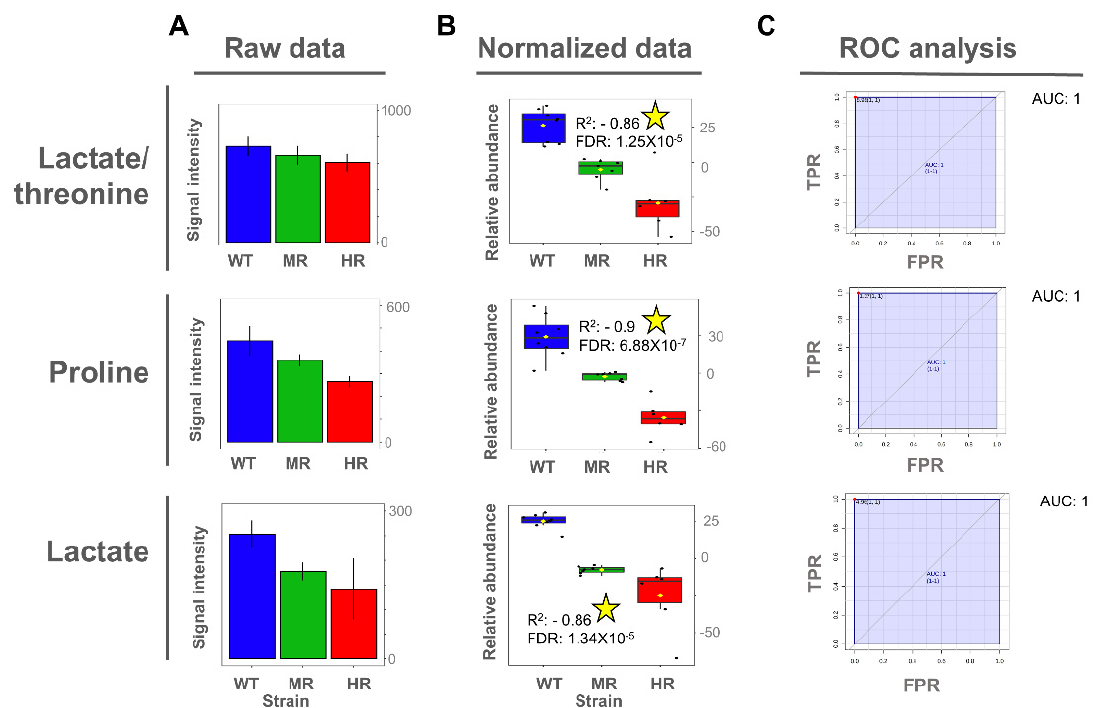
Figure 7. Lactate, proline, and threonine as potential biomarkers of antimony resistance at the extracellular level. ( A ) Bar plot of metabolite concentration as the raw intensity values. ( B ) Box plot of metabolite concentration as the normalized intensity values and showing the Pearson correlation scores. ( C ) Univariate ROC analysis comparing Sb III -resistant (MR and HR) vs. -sensitive strains (WT). Coefficient of determination by Pearson correlation (R 2 ). False discovery rate of the p -values obtained for the R 2 score (FDR). Significant high correlations (FDR ≤ 0.05) are highlighted with a yellow star. Sensitivity or true positive rate (TPR). Specificity or false positive rate (FPR). Area under the curve for univariate ROC analysis (AUC).